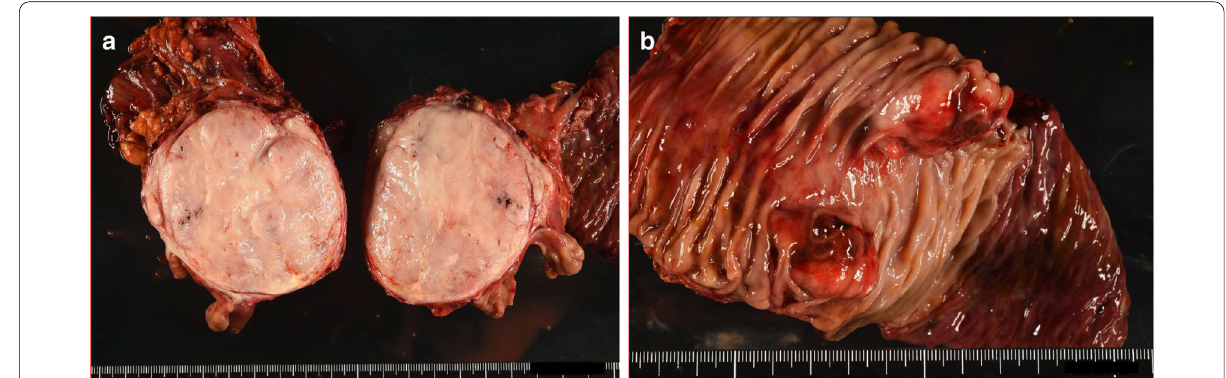
Fig. 4 Macroscopic images of the resected specimen seen as a solid tumor located in the pancreatic head. The cut surface of the tumor is well-demarcated, heterogeneous, and yellowish-white in color ( a ). Small prominent lesions are seen in the duodenal mucosa, which were considered tumor invasion ( b